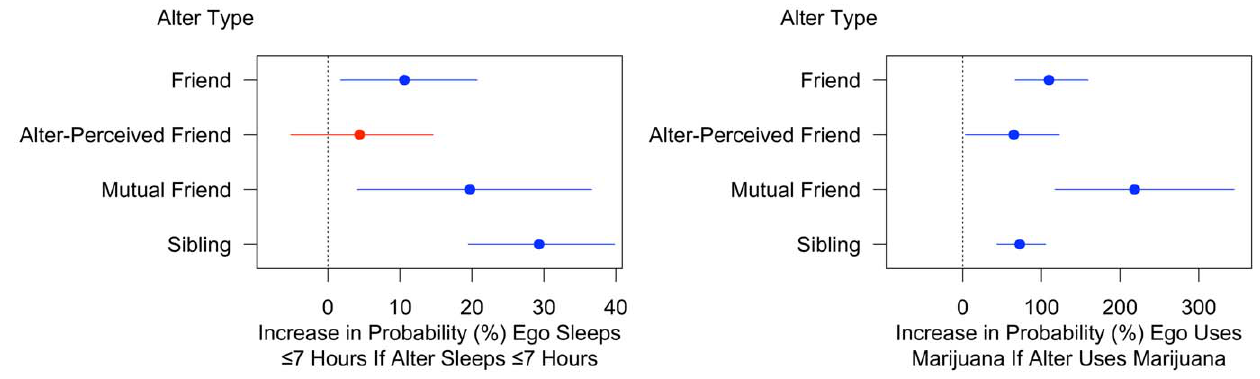
Figure 3. Influence of friends and siblings. Figure 3 shows that friends and siblings significantly influence drug use and sleep behavior. Effects are estimated using generalized estimating equation (GEE) logit models of sleep and drug use on several different sub-samples of the Add Health social network; see Text S1 for the underlying models. doi:10.1371/journal.pone.0009775.g003 PLoS ONE |